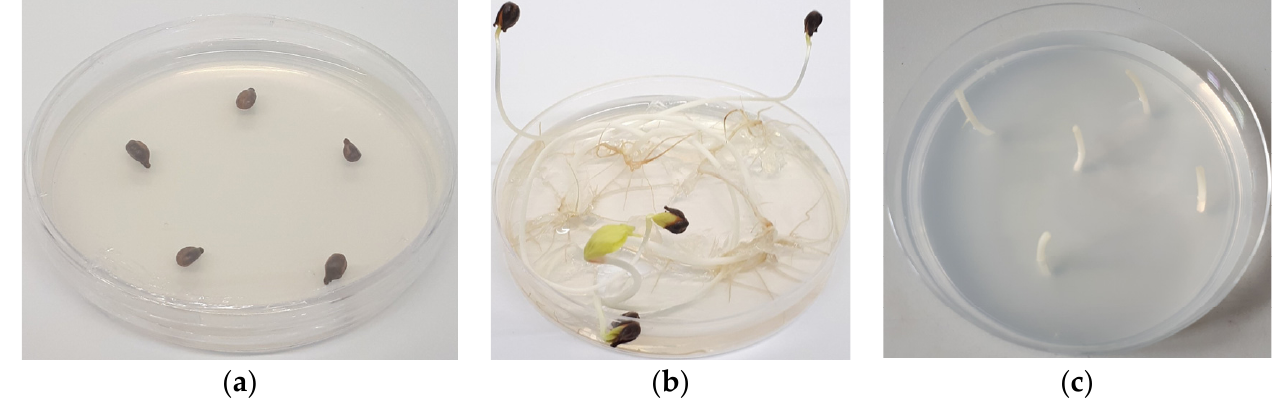
Figure 5. ( a ) Vialla seeds ( Vitis labrusca × Vitis riparia ); ( b ) etiolated hypocotyls of Vialla ( Vitis labrusca × Vitis riparia ); ( c ) sectioned hypocotyls into